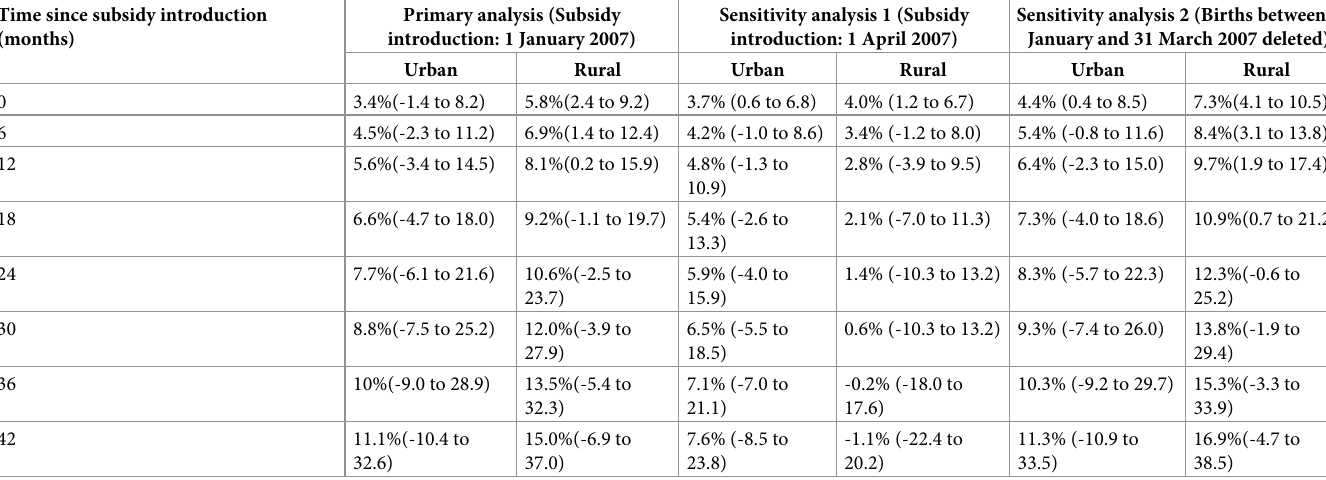
Table 5. Rate differences (RDs) with corresponding 95% Confidence intervals (CIs) for sssociations between subsidy introduction and birth attendance in a health facility over time across urban and rural locations in Burkina Faso. Time since subsidy introduction (months)